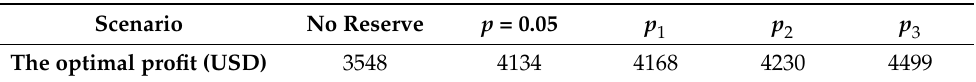
Figure 10. The RES operational scheduling with scenario p 1 of the reserve probability: ( a ) The reserve bid is called on to produce; ( b ) the reserve bid is not called on to produce.